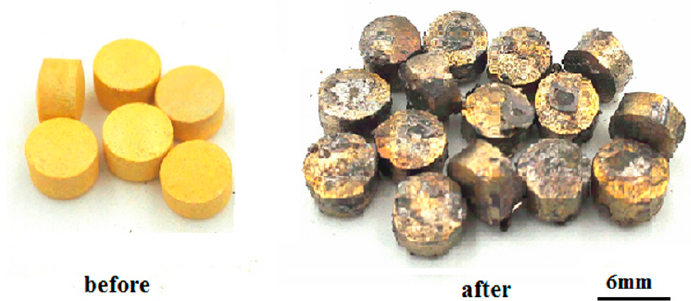
Figure 5. The 3 wt.% Bi 2 O 3 -97 wt.% PbO pellets before and after the flushing experiment.